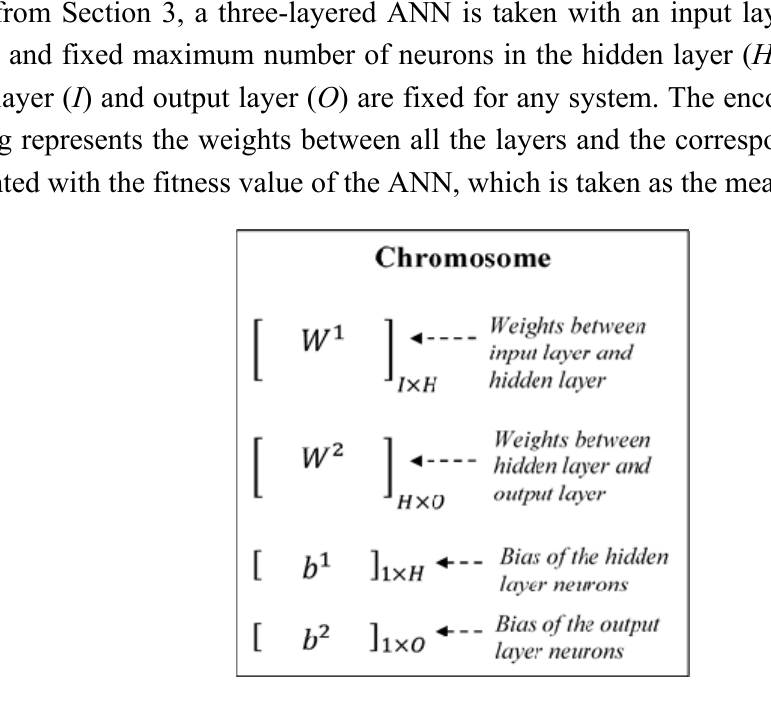
Figure 2. Structure of a chromosome.